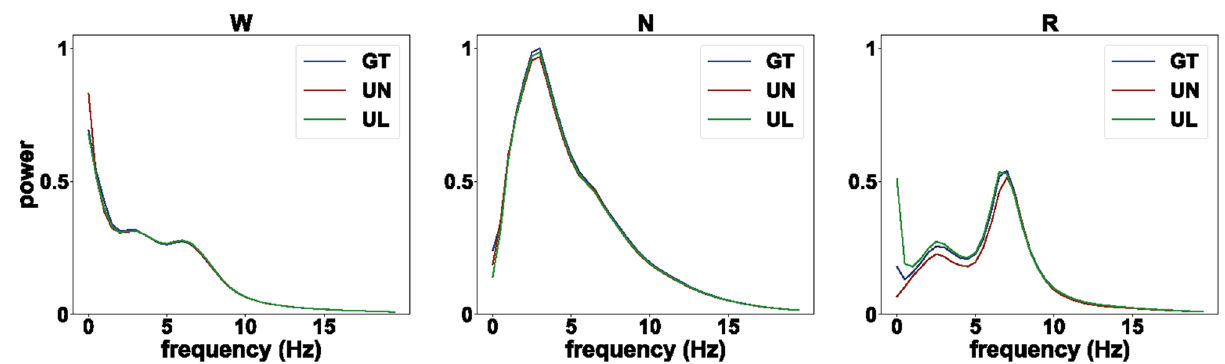
Figure 4. Power spectrum analysis from testing. Power was normalized by the total power (0.5–20 Hz) for each stage. Note the clear peaks within delta range (1–4 Hz) in NREM and theta range (6–9 Hz) in REM. W, wakefulness; N, NREM; R, REM; GT, ground truth; UN, UTSN; UL, UTSN-L; average from n = 22